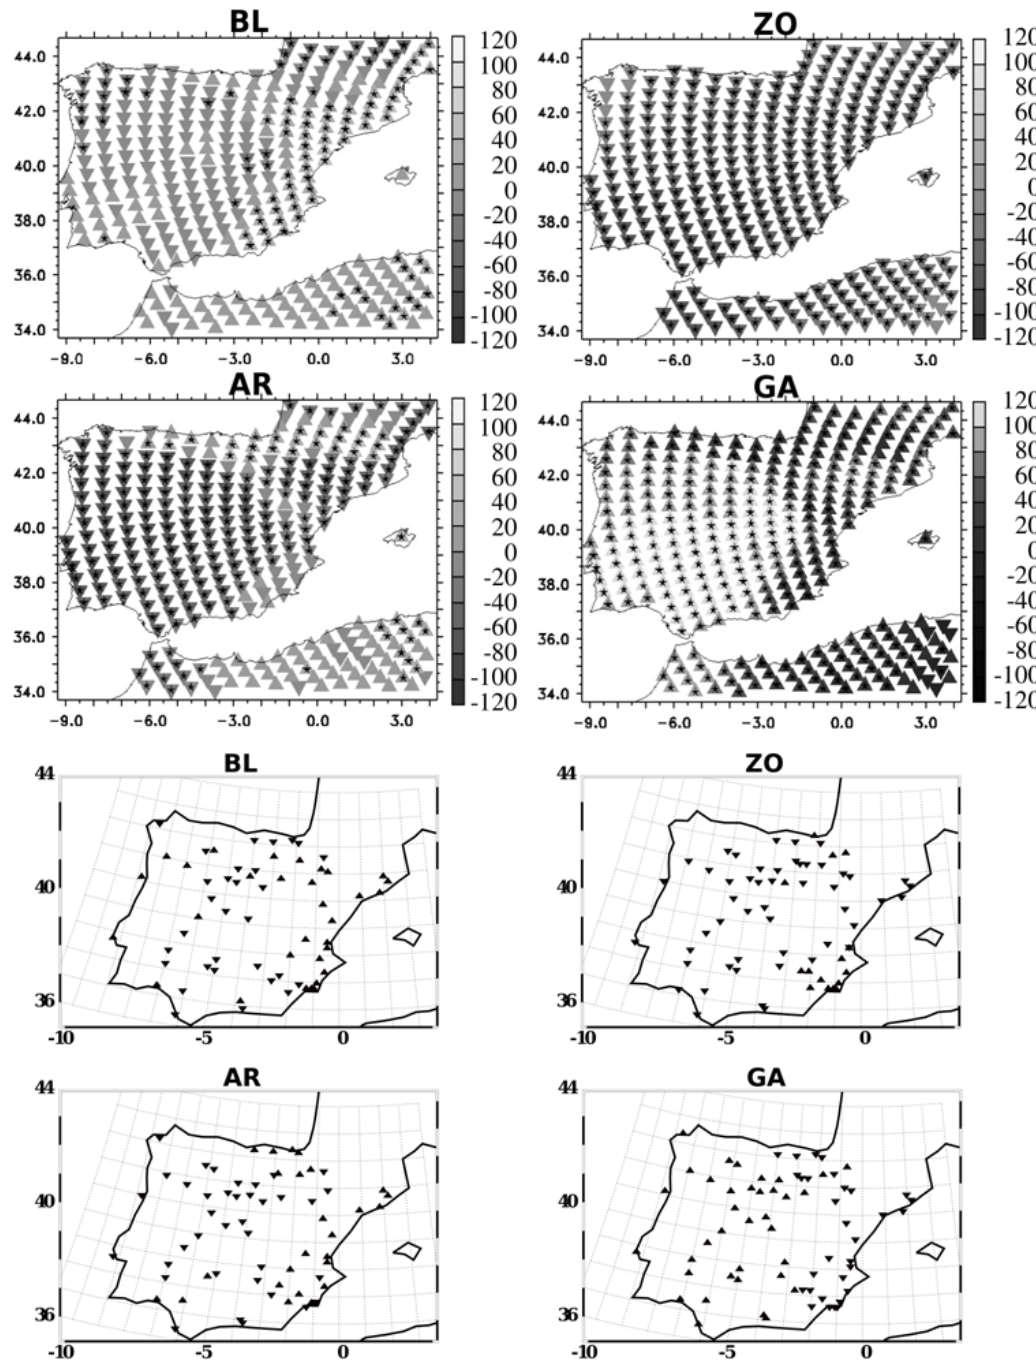
Fig. 2. Dependence of extreme values of precipitation on LAR. First and second row, the dependence in the historical simulations: first row, BL (left), ZO (right), second row, AR (left), GA (right). Up tipped triangles denote increases (with respect to the pooled decile values), down- tipped triangles, decreases. Asterisk mark statistical significance, grey scale, percent of exceedance. Third and fourth row, the dependence in the observations: third row, BL (left), ZO (right), fourth row, AR (left), GA (right). Up-tipped triangles denote increases (with respect to the pooled decile values), down-tipped triangles, decreases. The grey scale to the right indicates the exceedance percentage. When the light shaded triangles are significant, an asterisk is added (dark shaded triangles are always